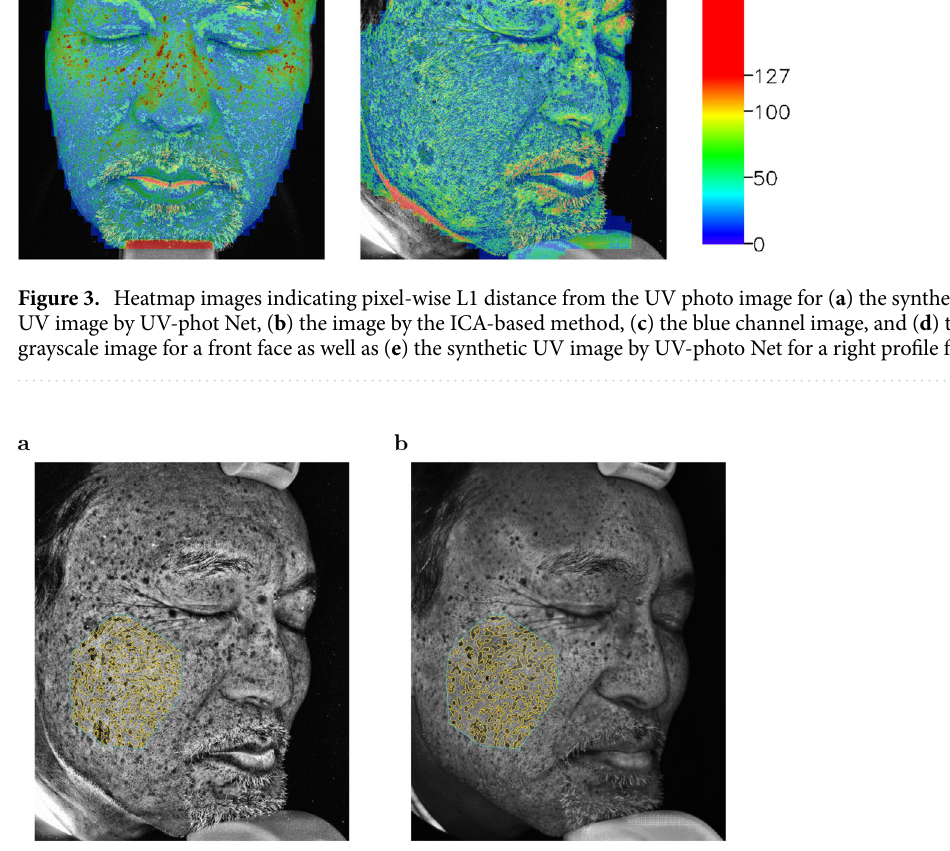
face images for samples included in the training samples. Figure 4a shows pigment spots detected by Spot Net for a cheek region of the UV photo image in Fig. 2f. Spot Net well reproduced pigment spots detected by the VISIA system for the same UV photo image as shown in Supplementary Fig. 5. Figure 4b shows pigment spots detected